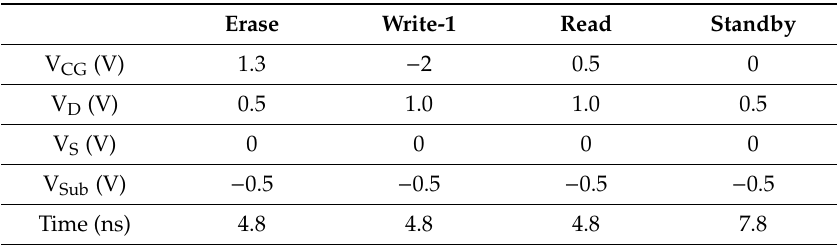
Figure 2. ( a ) Doping the concentration distribution of the SFG transistor based on an SOI substrate. ( b ) Low-speed hysteresis transfer curve of the device. ( c ) The normalized reading and writing operation currents of the device. ( d ) Changes in the SFG potential during one cycle.